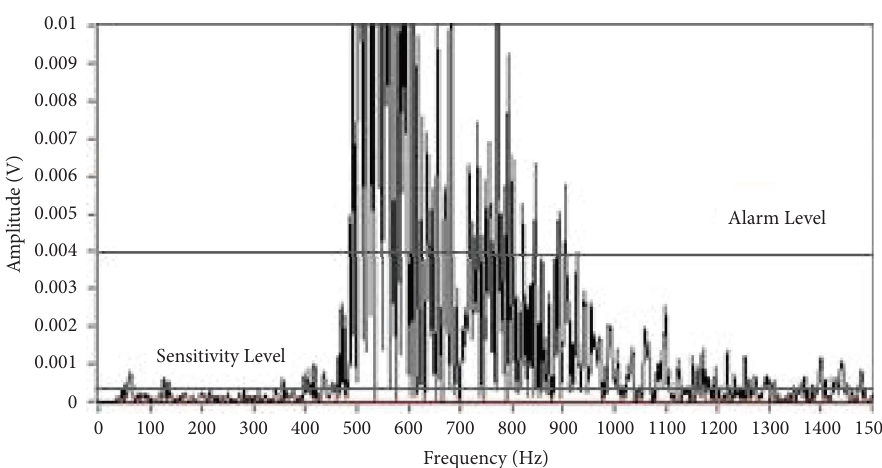
Figure 8: Captured FFT peaks of UAS fight over the radar